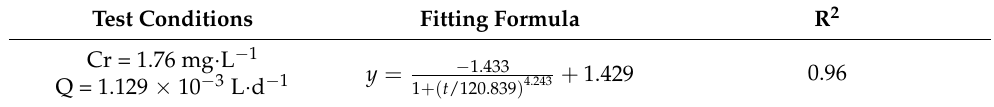
Table 4. Dynamics parameters of the